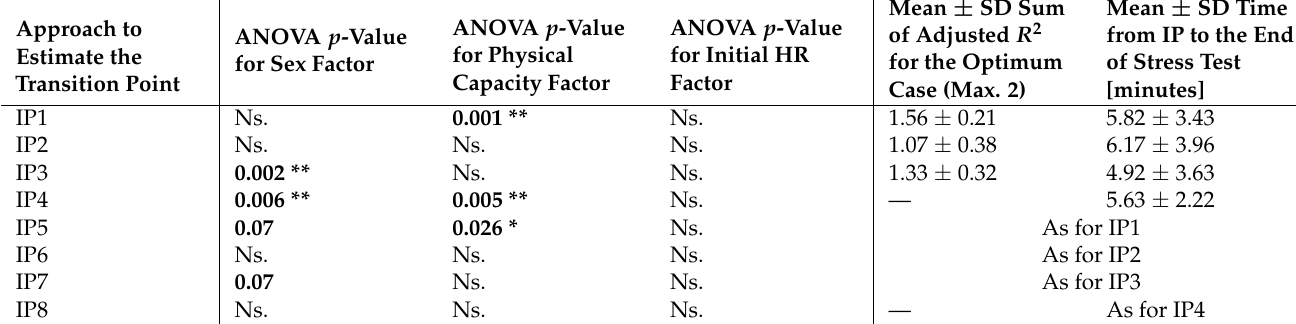
Table 3. The results of ANOVA analyses (only p -values lower than 0.1 were provided; otherwise, they are labeled as “Ns”.) and statistics of the sum of adjusted R 2 calculated for the optimum case and the time interval from found “inflection point” to the end of stress test. “*” means p -values between 0.05 and 0.01; “**” means p -values between 0.01 and 0.001.